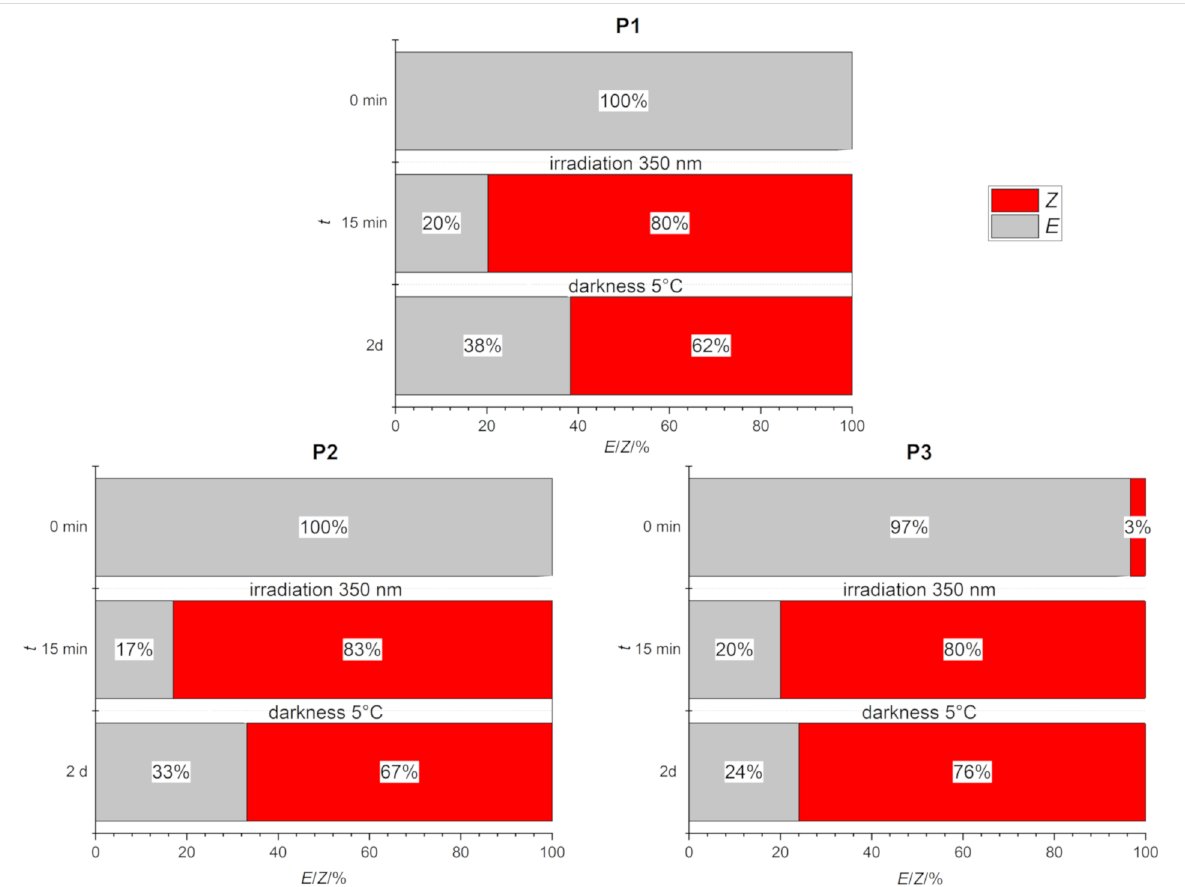
Figure 2: E / Z isomer ratio of the polyamides P1 – P3 . Values were obtained from the respective 1 H NMR experiments ( c = 0.80 mM) after irradiation ( λ = 350 nm, t = 15 min) followed by evaluation after one or two days at 5 °C in the dark. For details, see Supporting Information File